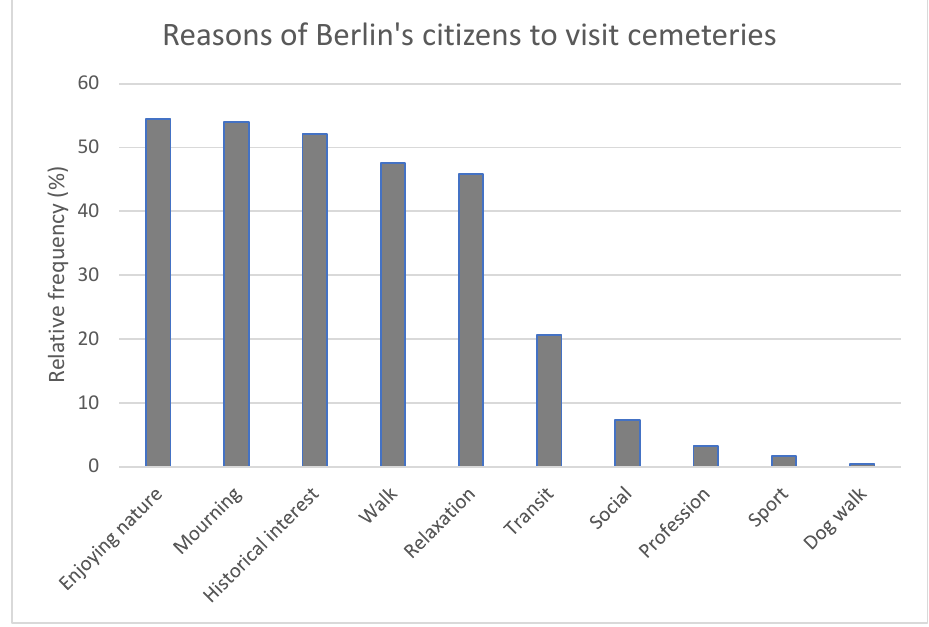
Figure 2. Relative frequency of the most common reasons of participants ( n = 627) to visit cemeteries in Berlin. Due to possible multiple responses, 1875 answers were generated.